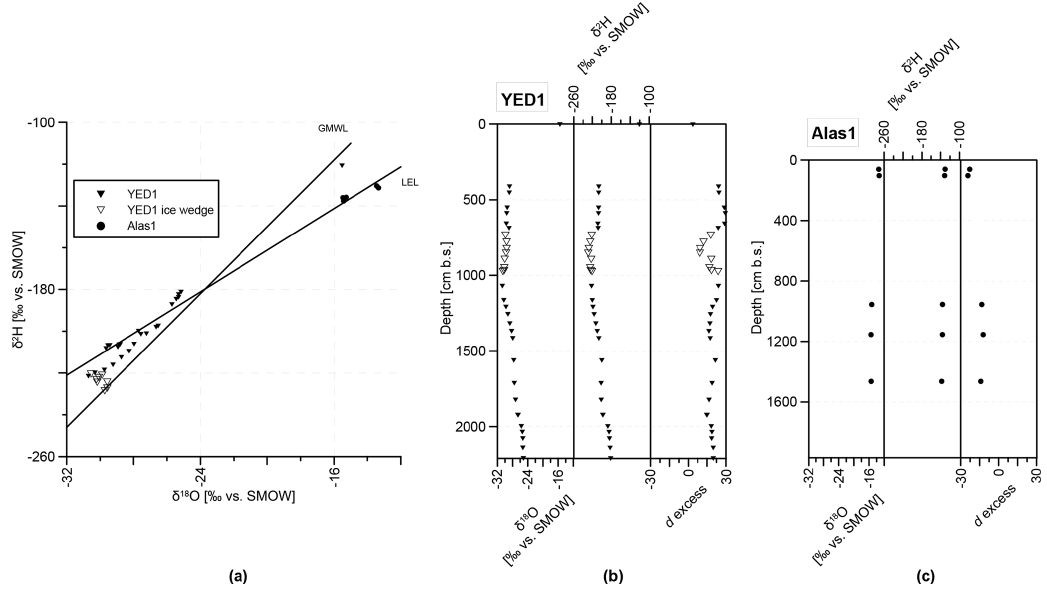
Figure 7. The characteristics of water stable isotopes in the studied sediment cores. (a) Stable hydrogen ( δ 2 H) and oxygen ( δ 18 O) isotope ratios of YED1 pore ice (black triangles), YED1 ice wedge ice (hollow triangles), and Alas1 pore ice and pore water (black dots; ‰ vs. SMOW). Global Meteoric Water Line (GMWL): δ 2 H = 8 · δ 18 O + 10; local evaporation line (LEL) of central Yakutia (based on data compiled until 2005 following Wetterich et al., 2008). (b) Oxygen isotopes, hydrogen isotopes and d -excess values of YED1 plotted over depth. (c) Oxygen isotopes, hydrogen isotopes and d -excess values of Alas1 plotted over